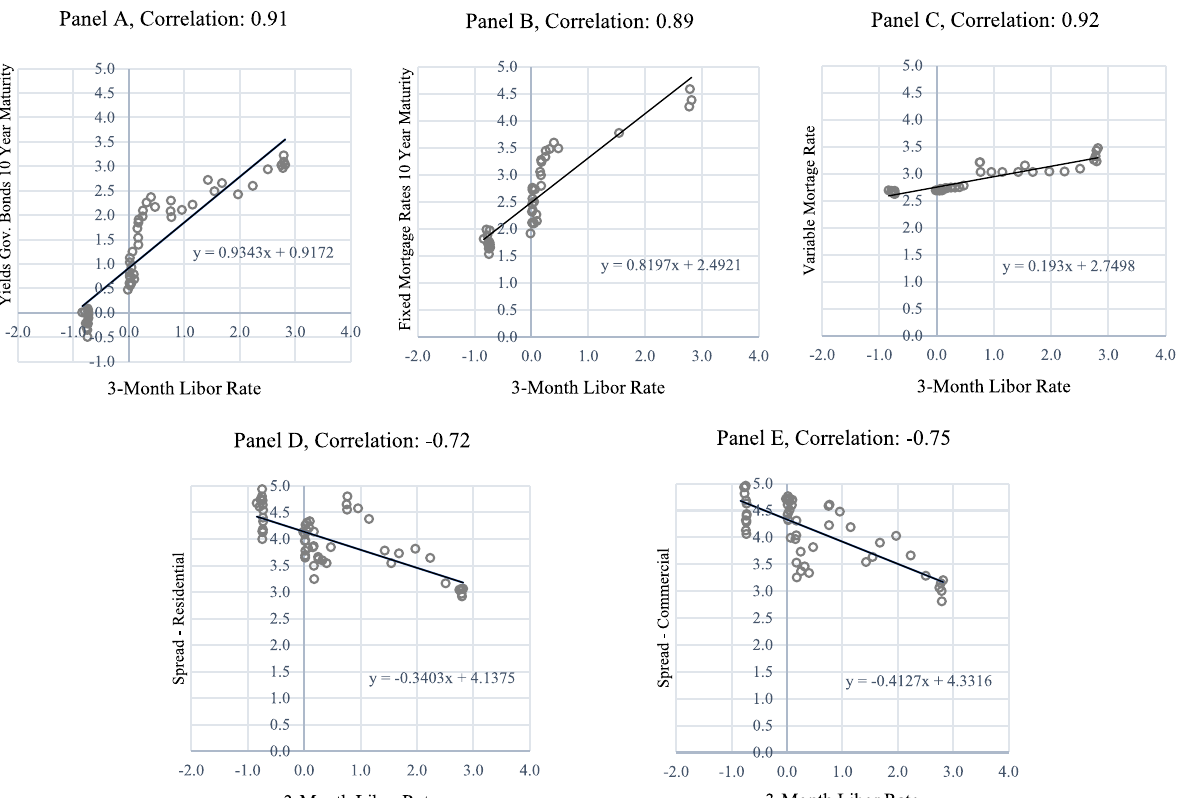
Fig. 4 Co-movement of real estate interest rates and the policy rate. Notes : Coefficients displayed within each panel are the results of a linear regression of interest rate representatives (vertical axis) on 3-month Libor rates (horizontal axis). The spread is defined according to Eq. (3.1), all the remaining interest rate representatives were taken from the SNB (data.snb.ch). Time series were averaged on a quarterly level. The represented time frame rages from 2005 Q1 to 2018 Q4 for Panel A , C , D , E , and from 2008 Q1 to 2018 Q4 for Panel B